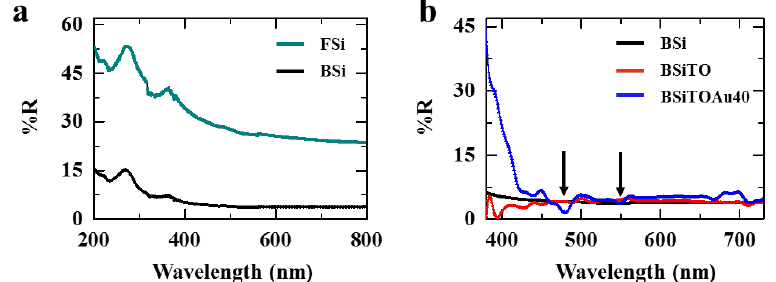
Figure 9. Comparison of optical spectra obtained from: ( a ) FSi and BSi; and ( b ) BSi, BSiTiO 2 (BSiTO), and BSiTiO 2 -Au 40 nm (BSiTOAu40) samples. The arrow marks indicate the enhancement of absorption in the BSiTOAu40 sample after adding the Au nanoparticles. Adapted from [82] with permission from Elsevier, 2018